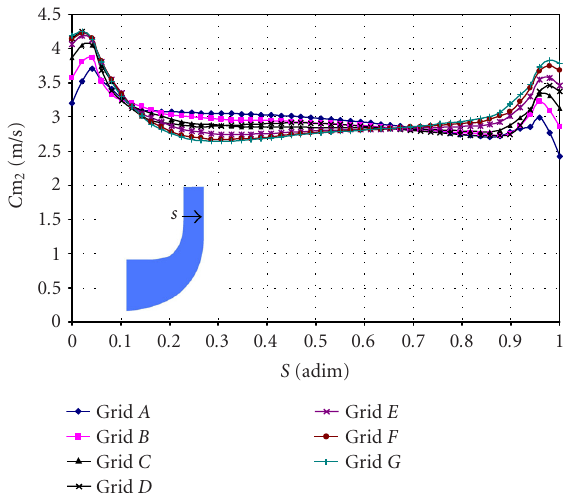
Figure 5: Influence of grid size on the meridional velocity at the trailing edge of the blade: CFX-TASCflow code and impeller NS32.